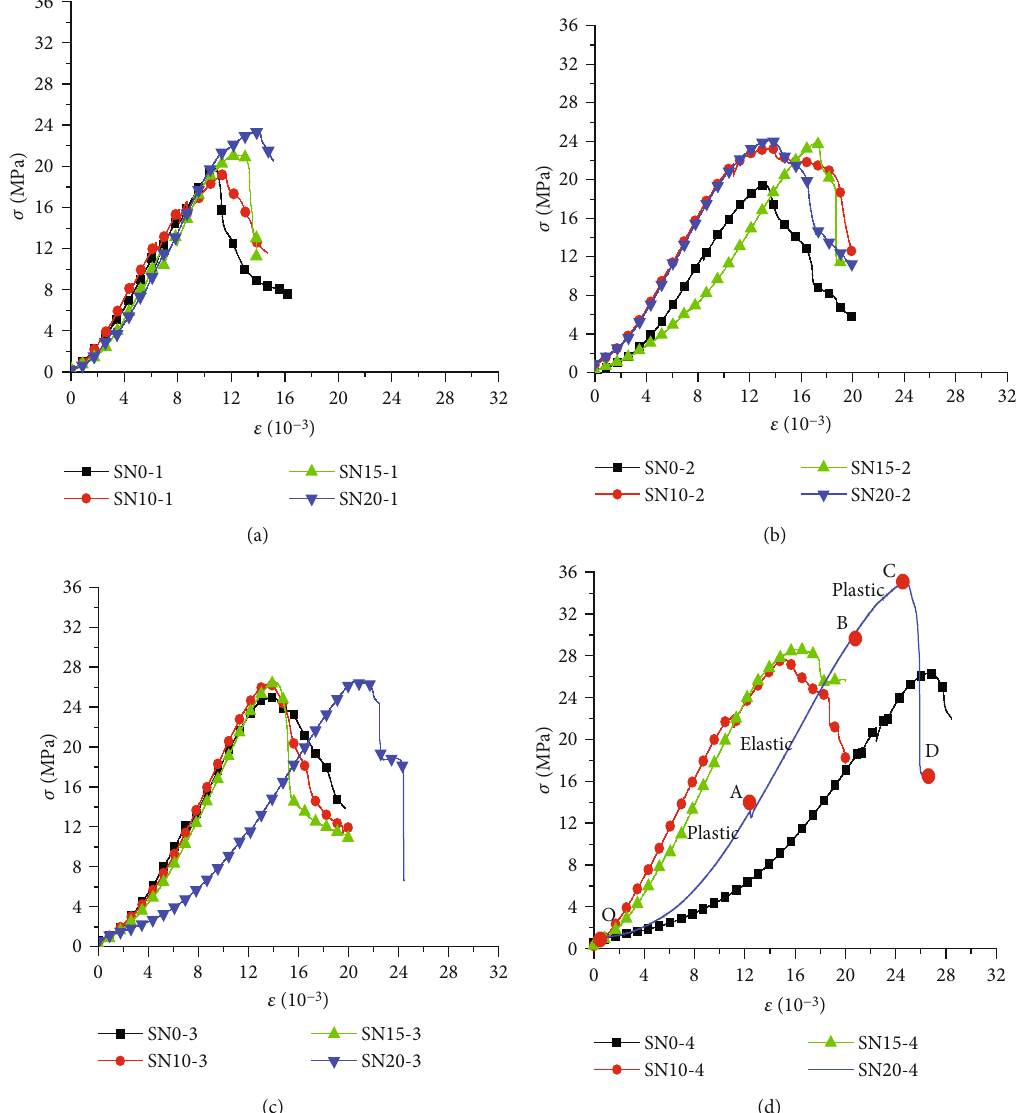
Figure 4: Axial stress-strain curve of the specimen under the same reinforcement condition and di ff erent lateral pressure conditions. (a) Lateral pressure is 0MPa. (b) Lateral pressure is 0.5MPa. (c) Lateral pressure is 1MPa. (d) Lateral pressure is